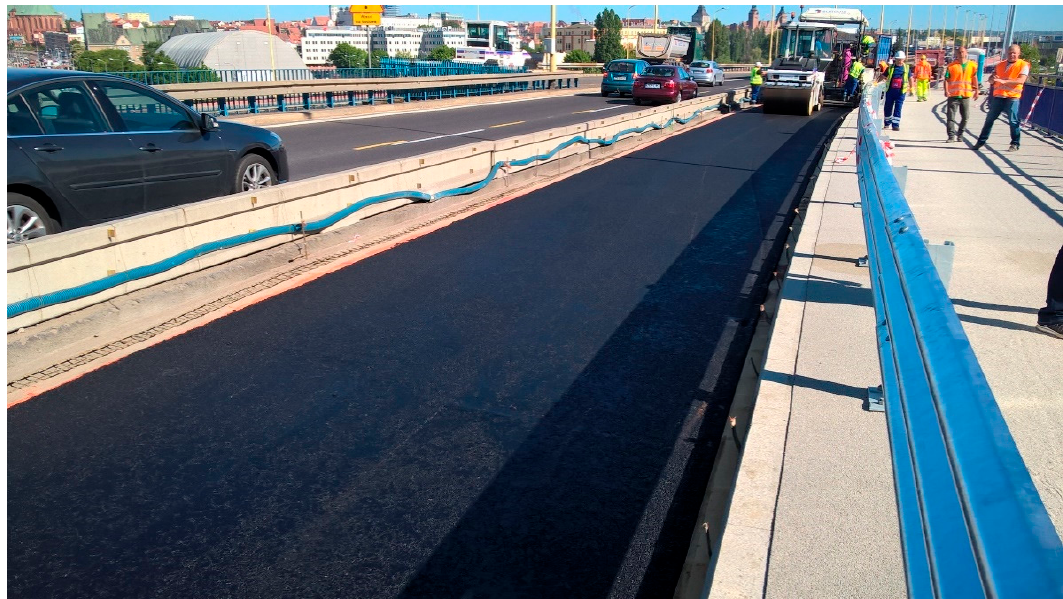
Figure 15. Compaction of the SMA-MA 8 PMB 45/80-65 protective layer.